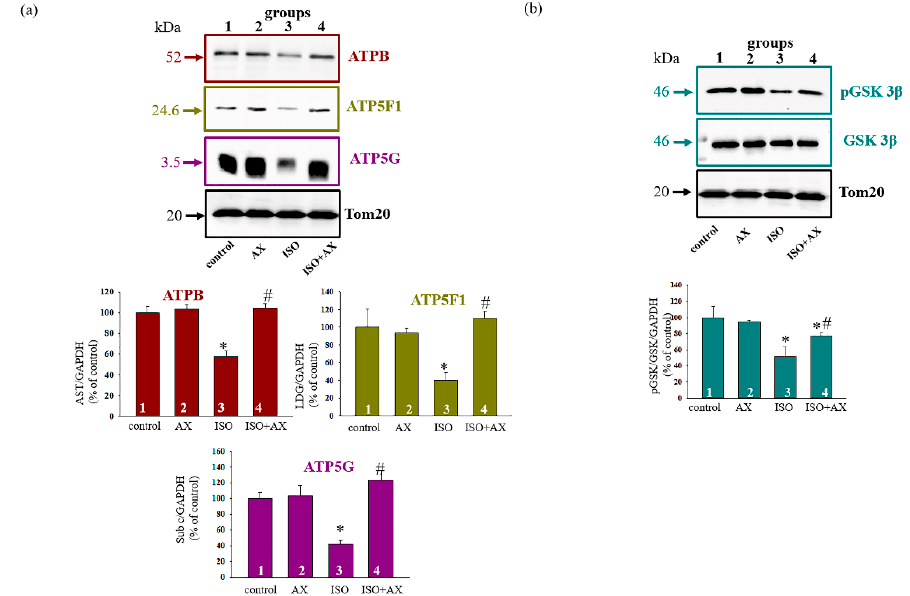
Figure 5. Effects of the administration of AX on the content of ATPB, ATP5F1, ATP5G, pGSK3 β and GSK3 β in rat heart mitochondria in heart failure. ( a )—immunostaining with ATPB, ATP5F1, ATP5G, and Tom20 antibodies (upper part); low part—quantification of immunostaining by computer-assisted densitometry presented as a ratio of proteins to Tom20; ( b )—immunostaining with pGSK3 β , GSK3 β , and Tom20 antibodies (upper part); low part—quantification of immunostaining by computer-assisted densitometry presented as a ratio of proteins to Tom20. Bar graphs represent the levels of appropriate proteins; the data are presented as the means ± SD of three independent experiments. * p < 0.05 significant difference in the protein level in comparison with the control (group 1). # p < 0.05 compared to RHM isolated from ISO-injected rats (group 3). The statistical significance of the differences between the pairs of mean values was evaluated using the Student-Newman-Keul